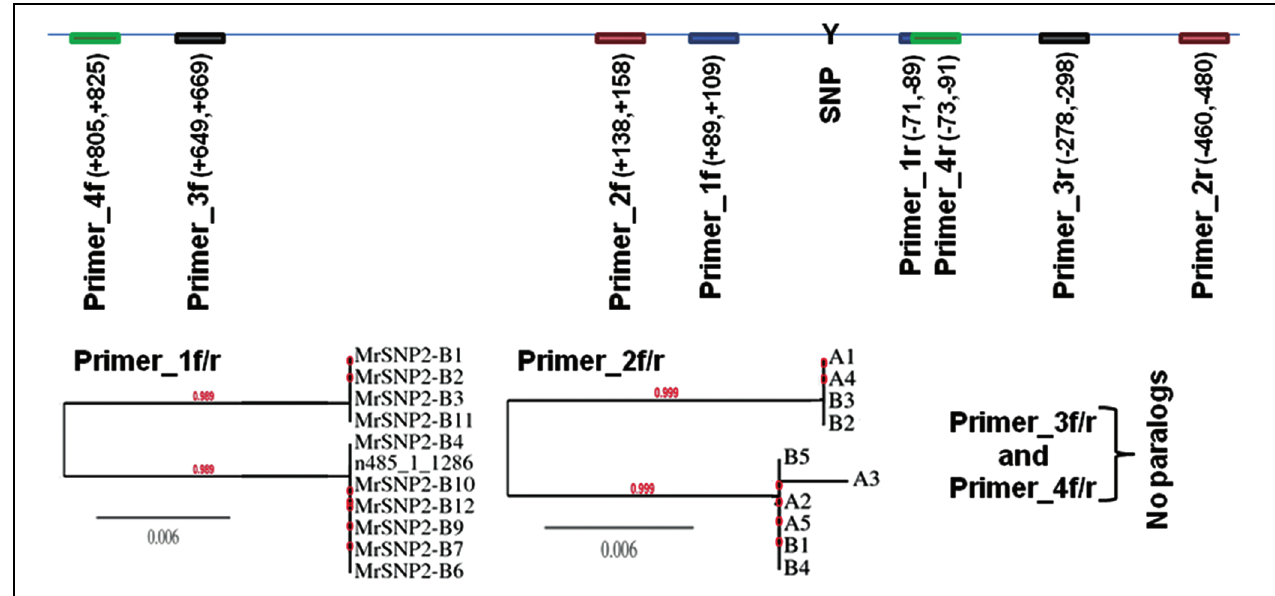
FIGURE 2 | Sanger sequencing of partial genomic DNA flanking the putative heterozygous SNP marker 485_1_1286 as called by SAMtools mpileup and bcftools with default parameters from M. roreri isolates C13. PCR-amplicons were cloned into pCR4-TOPO vector followed by transformation into DH5-alpha Escherichia coli and 9–11 clones from each